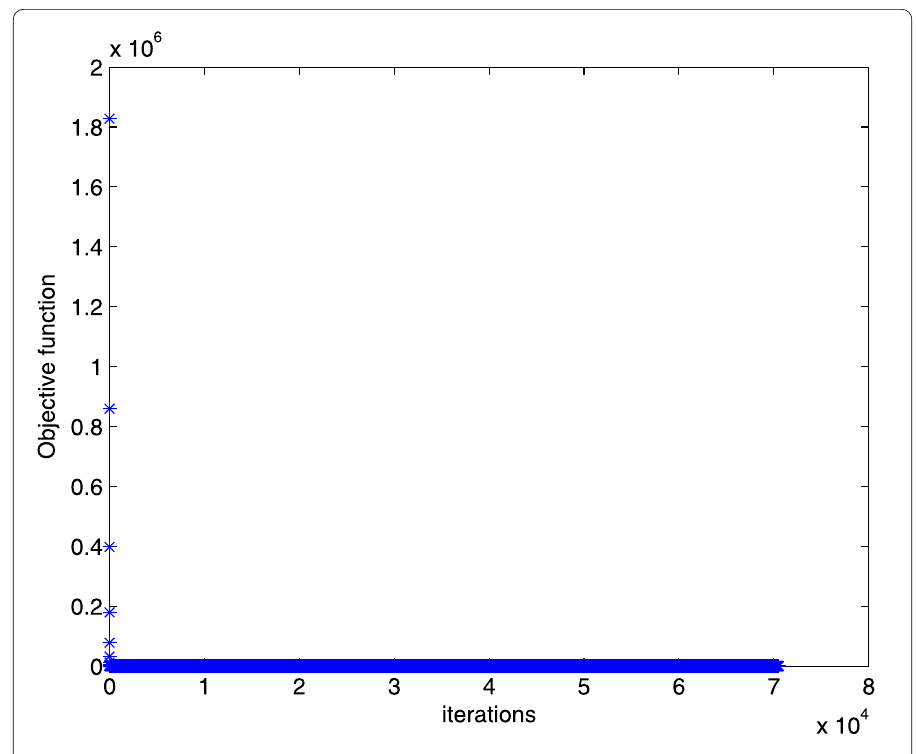
Figure 2 Numerical results for solving Example 1 with smoothing gradient method